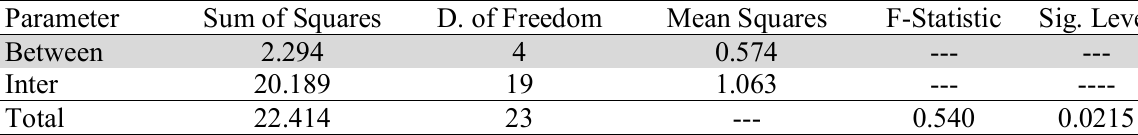
The Summary of Parametric ANOVA Parameter Sum of Squares